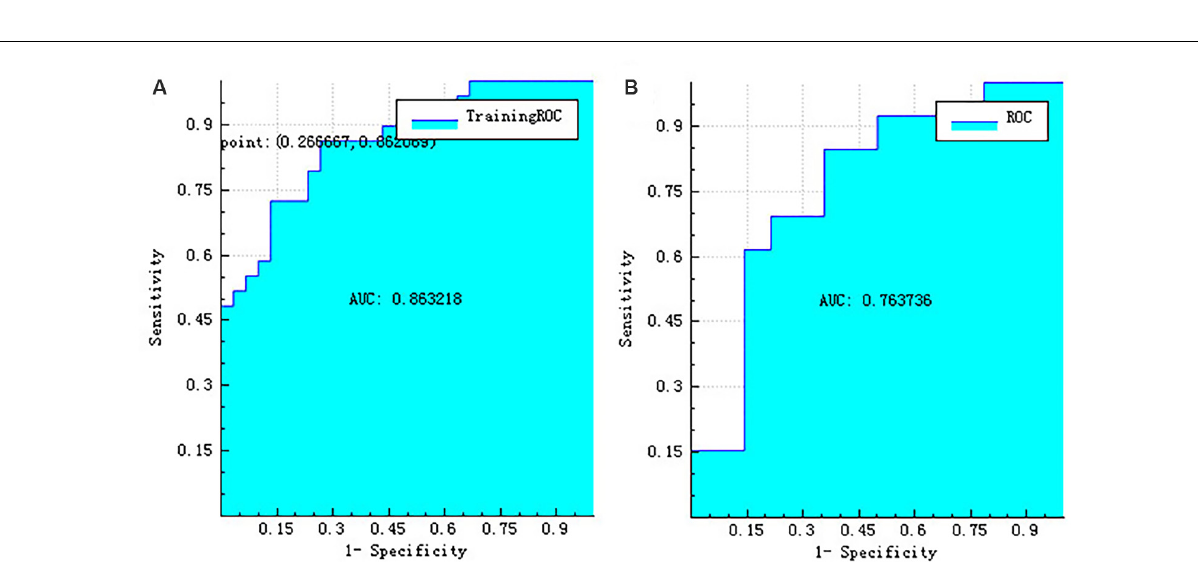
Frontiers in Aging Neuroscience | www.frontiersin.org